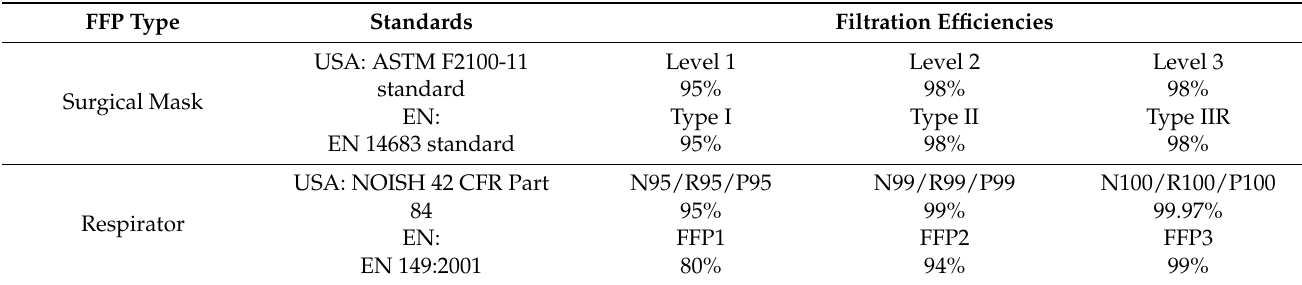
Table 1. American Society for Testing and Materials and European Norm standards for face masks and respirators. FFP